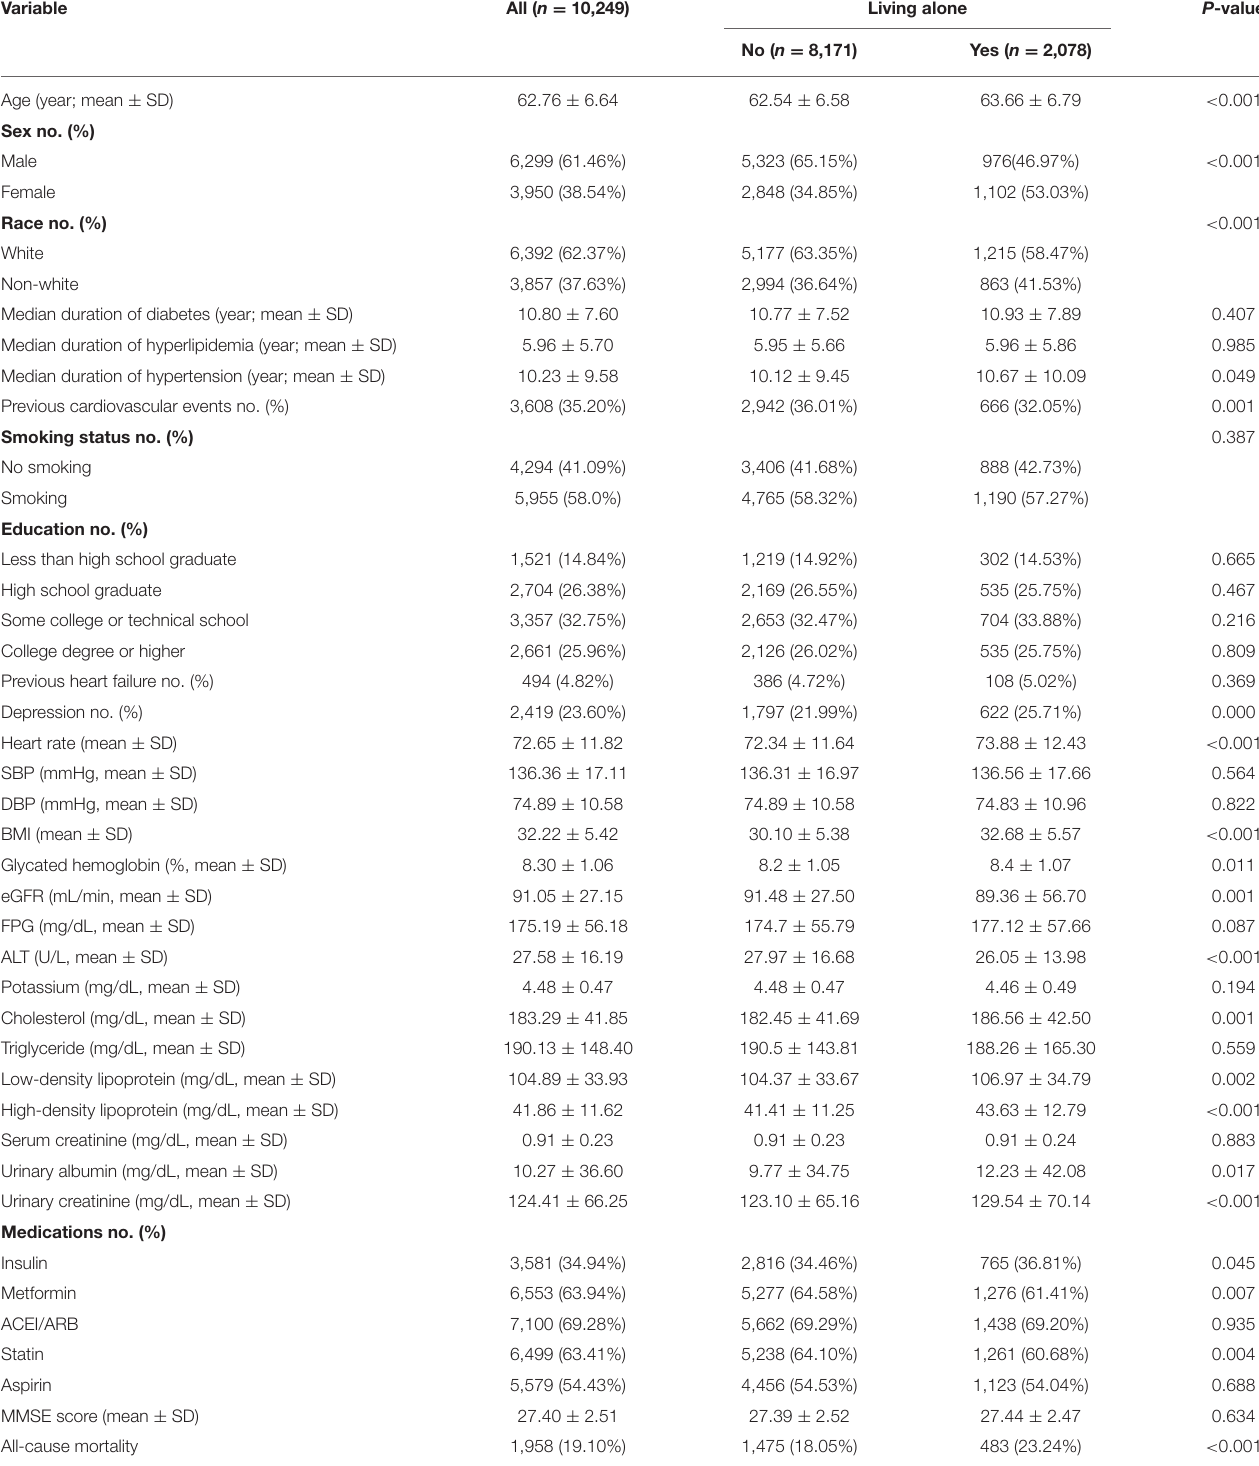
TABLE 1 | Characteristics of patients with different living status.